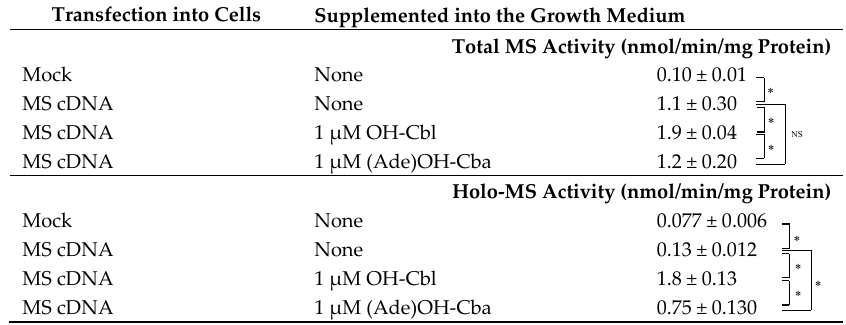
MS cDNA- or mock-transfected cells were cultured in the absence or presence of 1 µ M OH-Cbl or (Ade)OH-Cba for 2 days. Total and holo-MS activities in cells were determined with and without the addition of OH-Cbl into the reaction mixture, respectively. Data presented as mean ± SD ( n = 3). Asterisk (*) denotes significant di ff erences ( p < 0.05). No significant di ff erence (NS) was observed between total MS activity in MS cDNA-transfected cells cultured with or without